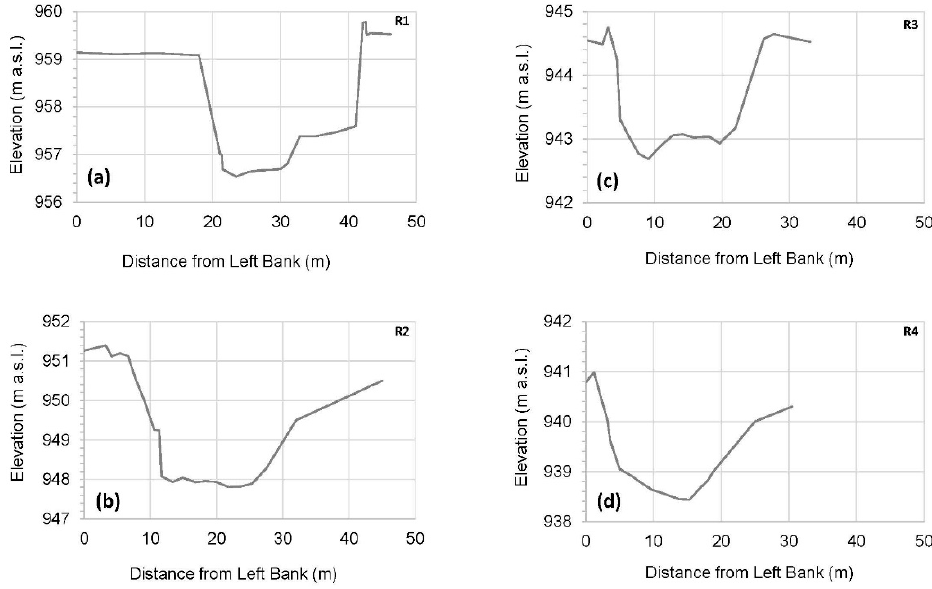
Figure 6. Representative cross-sections for the four study reaches: ( a ) Reach 1 (R1), ( b ) Reach 2 (R2), ( c ) Reach 3 (R3) and ( d ) Reach 4 (R4).